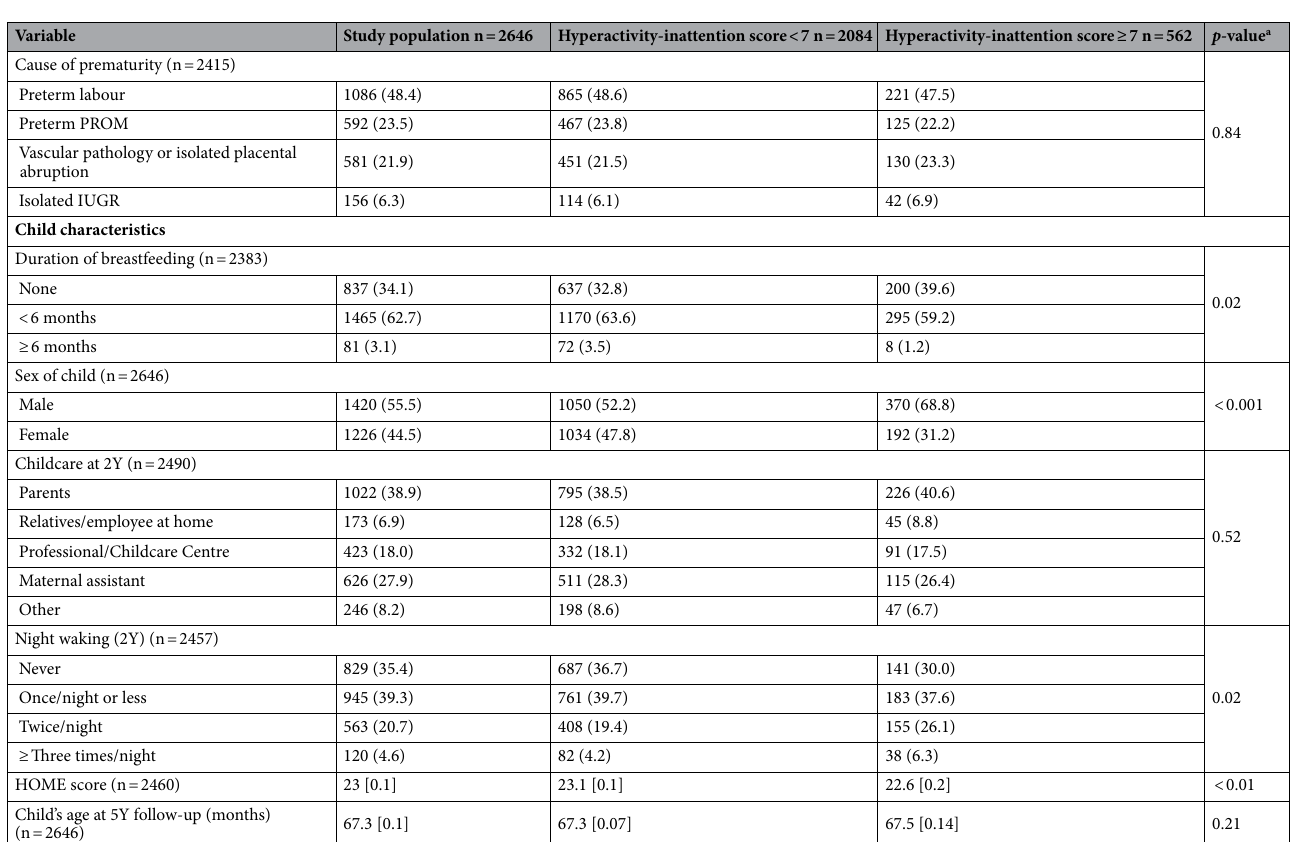
Table 2. Weighted descriptive characteristics of the overall population (N [%] or mean [STD]) and SDQ hyperactivity-inattention score in the EPIPAGE 2 study (n = 2646). Characteristics are weighted using sampling weights that take into account the different periods of recruitment by gestational age group. a Difference by hyperactivity-inattention score, by ANOVA or by chi 2 test. BMI body mass index, IUGR intrauterine growth restriction, HOME Home Observation Measurement of the Environment-Short Form, PROM premature rupture of the membranes. *Chi 2 test statistic not calculated due to the 0 cell.